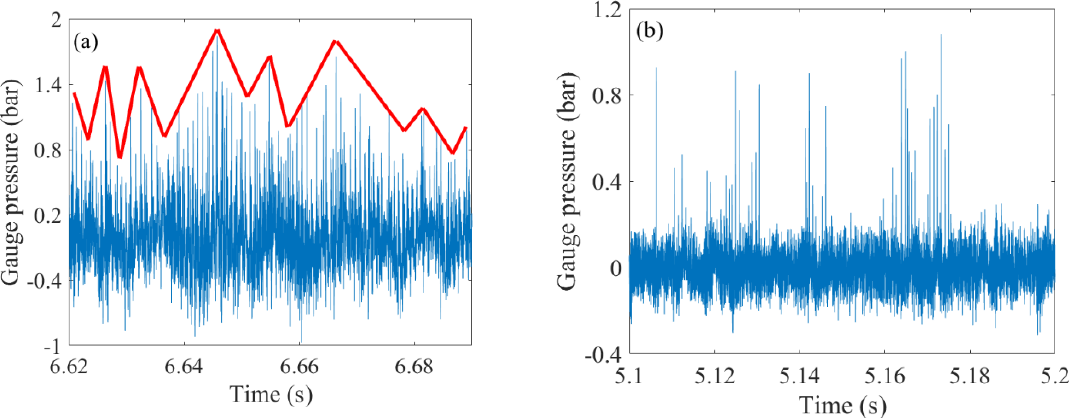
Figure 9. Instability phenomena: ( a ) low − frequency oscillation and ( b ) sporadic detonation. For the selected time period of test B4, the detonation wave did not realize continuous self ‐ sustained propagation. However, a detonation wave signal does appear at some